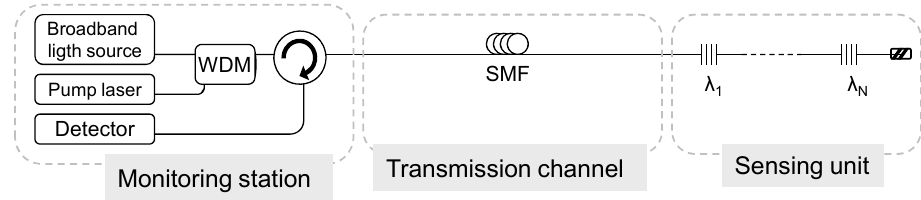
Figure 3. Conventional FBG sensor system with distributed Raman amplification. Adapted from